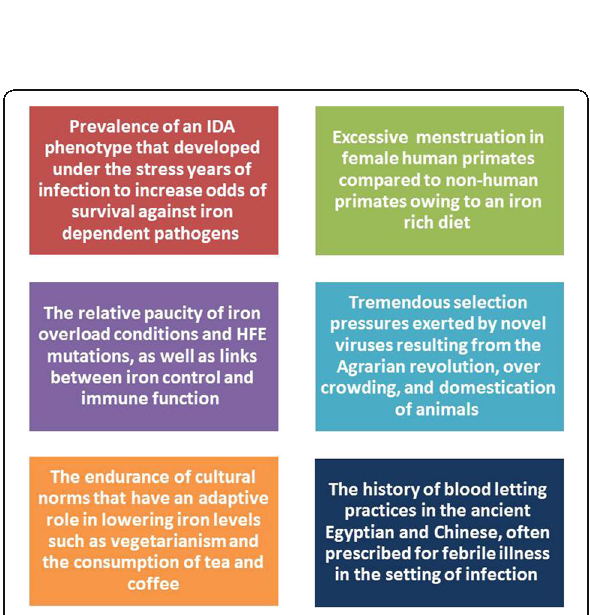
Fig. 5 Several evolutionary and social adaptations support the theory that a low iron state may have evolved to mitigate